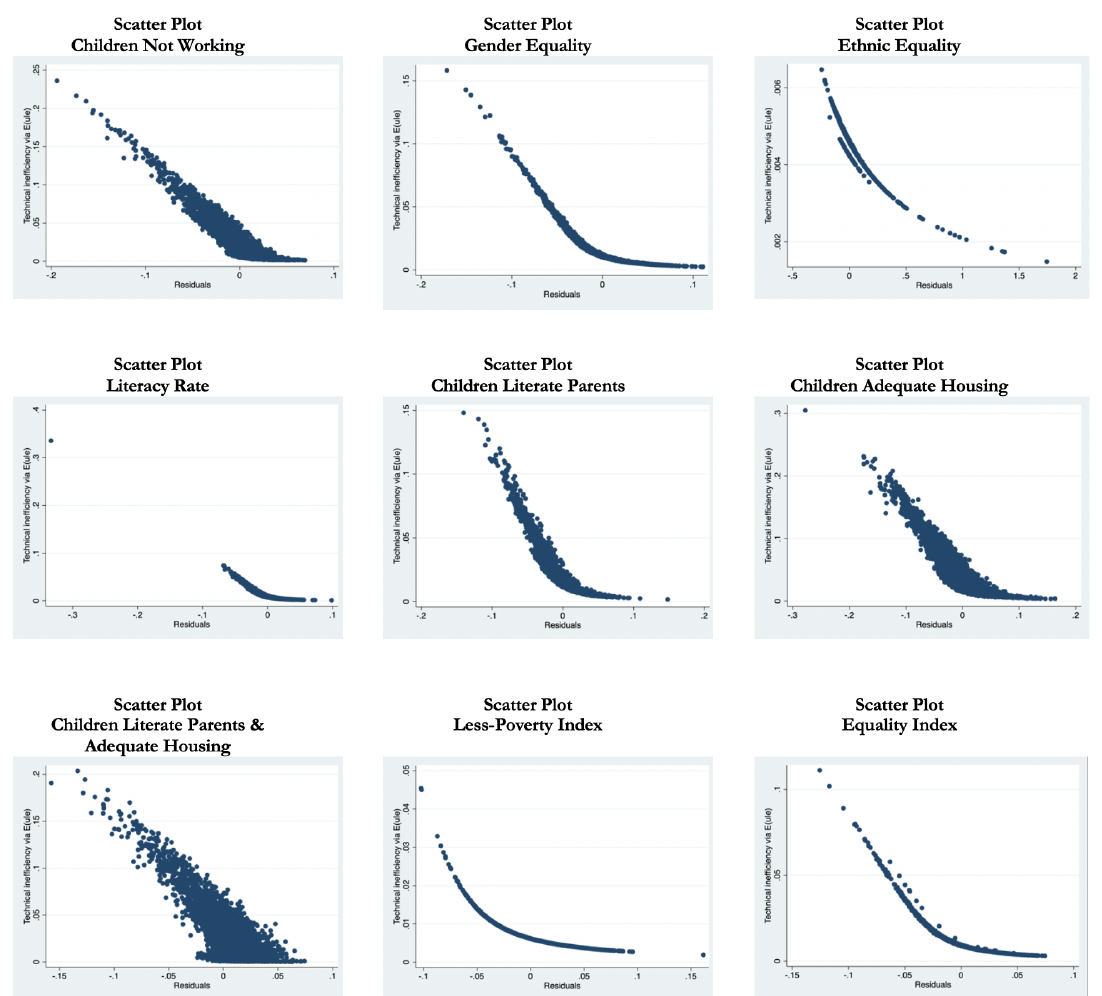
Figure 2: Correlation between ε i and the µ